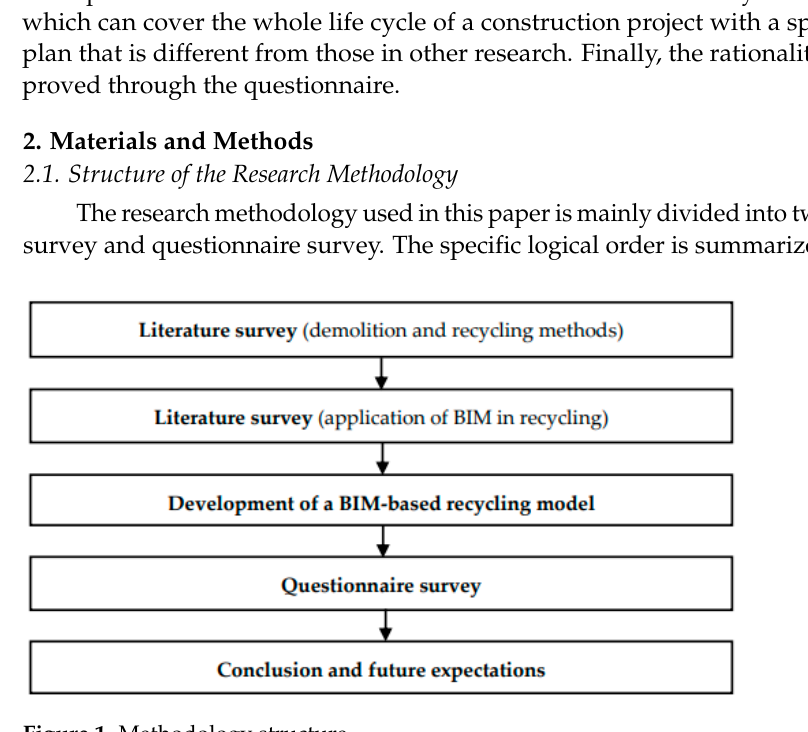
Figure 1. Methodology structure .